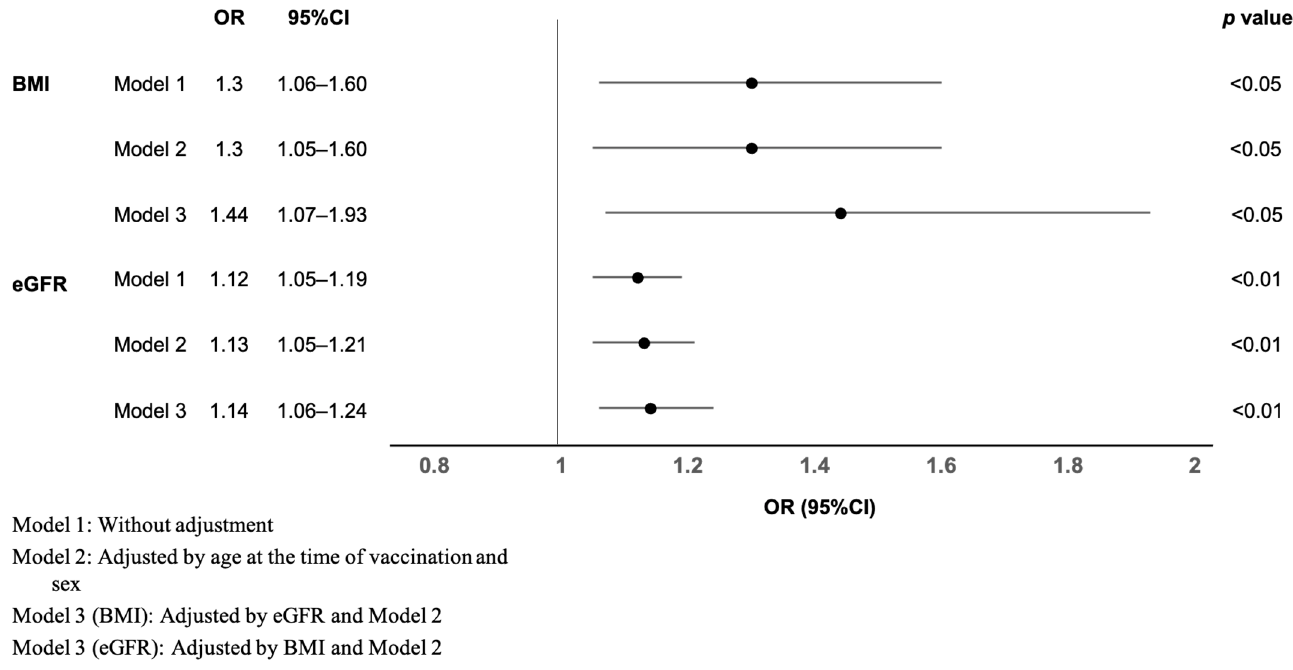
Figure 3. Clinical factors associated with S-IgG acquisition in post-kidney-transplant patients. OR: odds ratio; CI: confidence interval; BMI: body mass index; eGFR: estimated glomerular filtration rate. Table 3. Regression analysis for the increase in S-IgG titer from 5 – 6 months after 2 doses of vaccina- tion to 3 doses of vaccination. β 95% CI T p Value